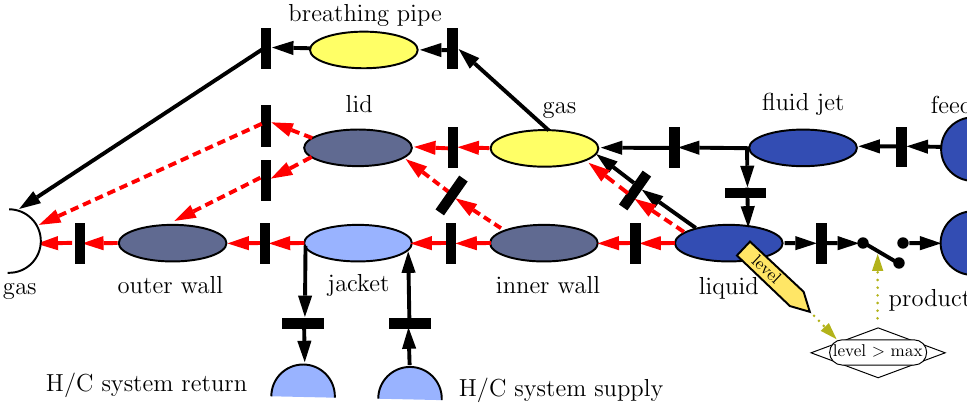
Figure 8. A relatively complex model without condensation on the